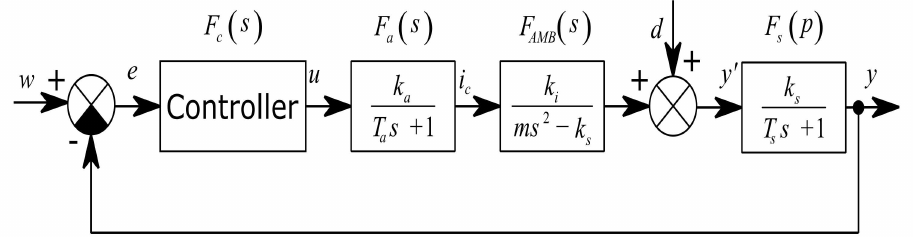
Figure 3. SISO model of AMB plant in closed loop